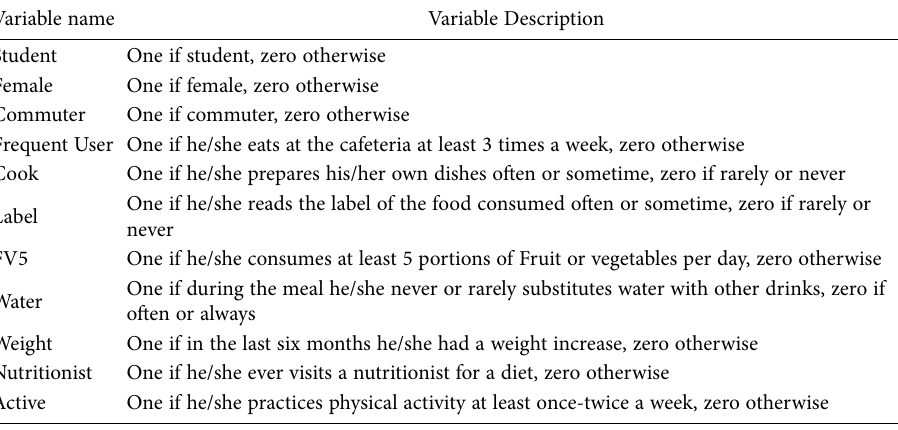
Table 2. Demographic and behavioral